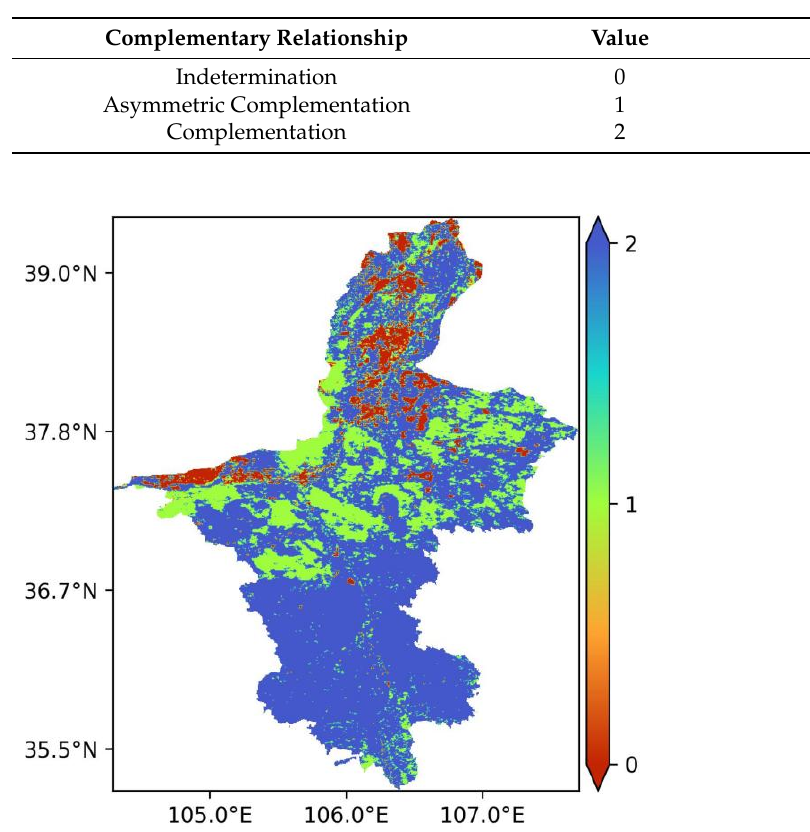
Table 8. Variation trend of EDI.